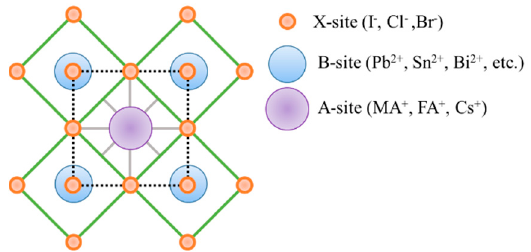
Figure 4. General crystal structure of metal halide perovskites.